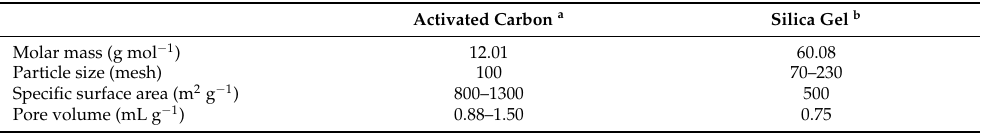
Table 2. Characteristics of activated carbon and silica gel. Activated Carbon a Silica Gel